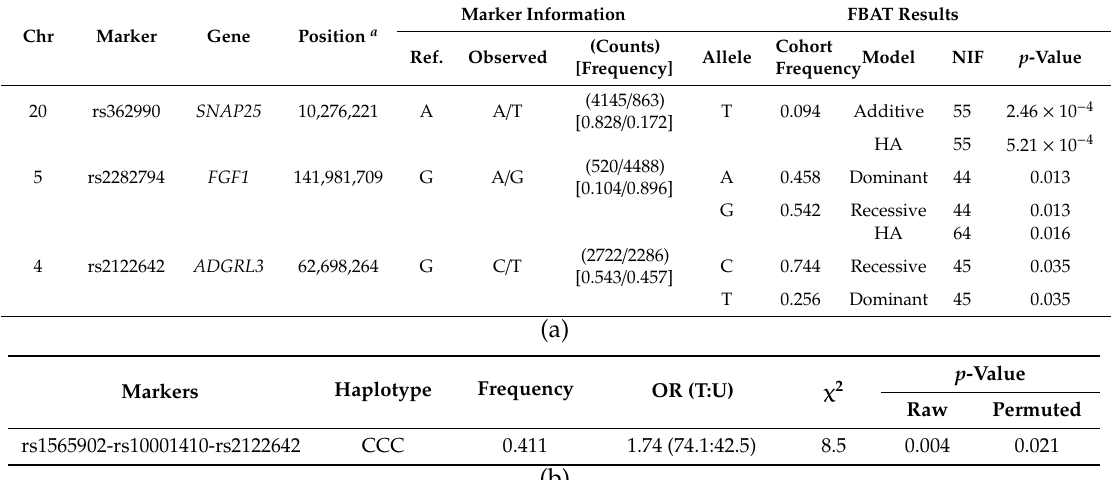
Table 3. Results of ( a ) family- and ( b ) haplotype-based association tests for ADHD in 386 individuals belonging to 113 nuclear families from a Caribbean